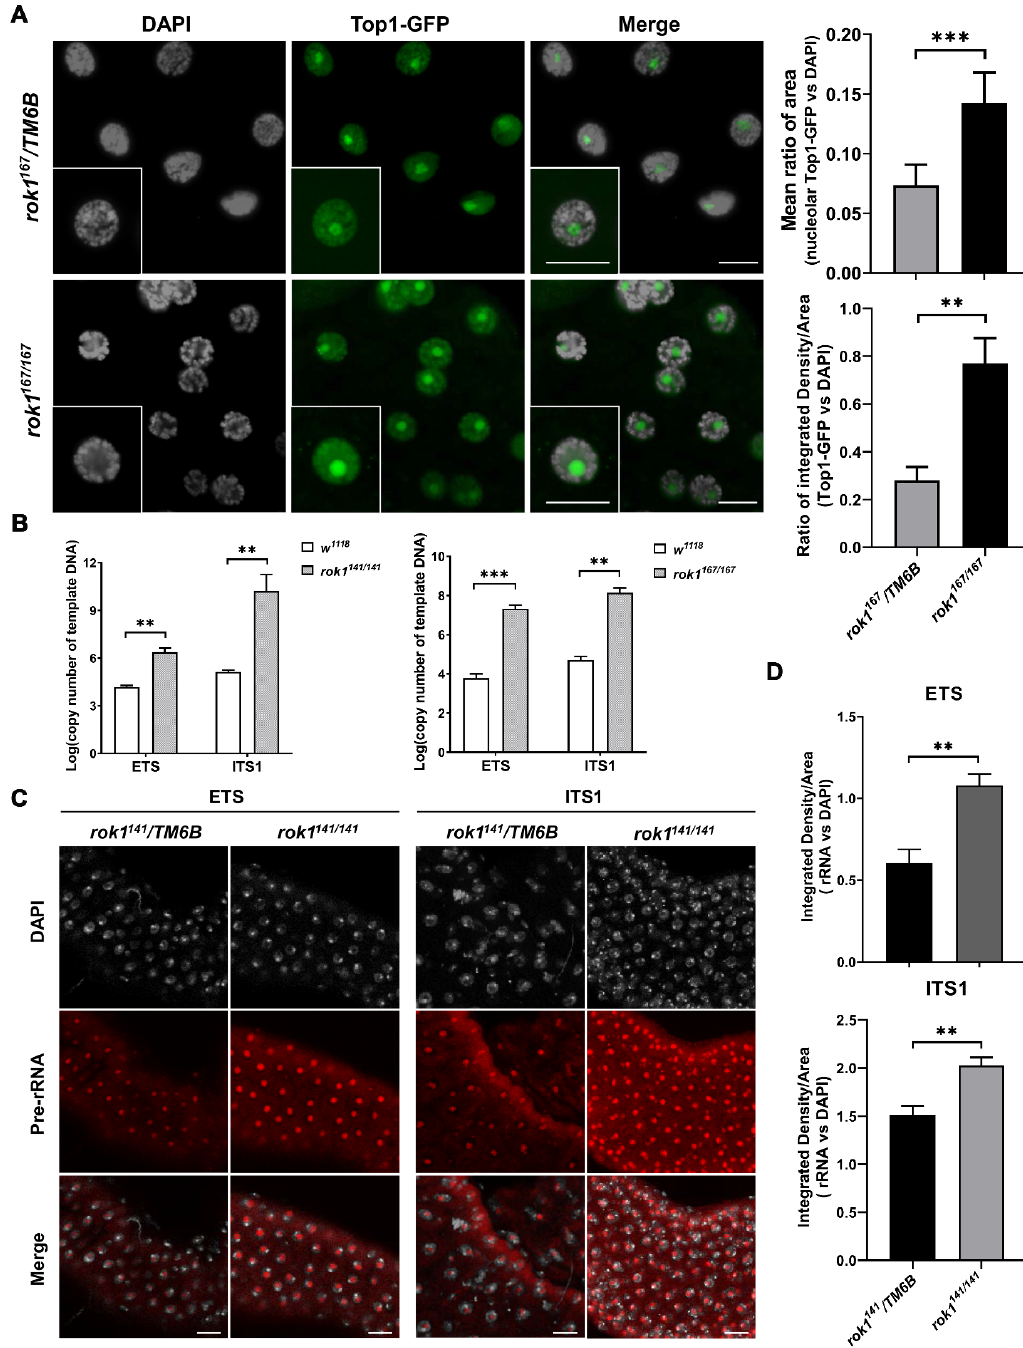
Figure 4. Loss of Rok1 leads to stalled ribosome assembly and pre-rRNA processing in the nucleolus. ( A ) Localization of Top1 in the salivary gland of rok1 167/167 mutants. Salivary glands from third-instar larvae of rok1 167 /TM6B and rok1 167/167 were dissected. Scale bar represents 40 µ m. Amplified areas marked with solid rectangles are shown as inserts. Mean ratio of area from salivary gland cells in each genotype is provided in panels to the right. Each point represents the mean ± SD ( n = 38). *** indicate significant differences between the two groups at p < 0.001 (unpaired t -test, SPSS). ( B ) The expression levels of ETS and ITS1 in rok1 mutants. Thirty second-instar larvae of w 1118 , rok1 141/141 , and rok1 167/167 were pooled as one sample. The initial copy numbers of ETS and ITS1 were calculated from the CT value of each cDNA sample after adjusting by the copy number of Act5C . Each point represents the mean ± SD ( n = 3). ** and *** indicate significant differences between the two groups at p < 0.01